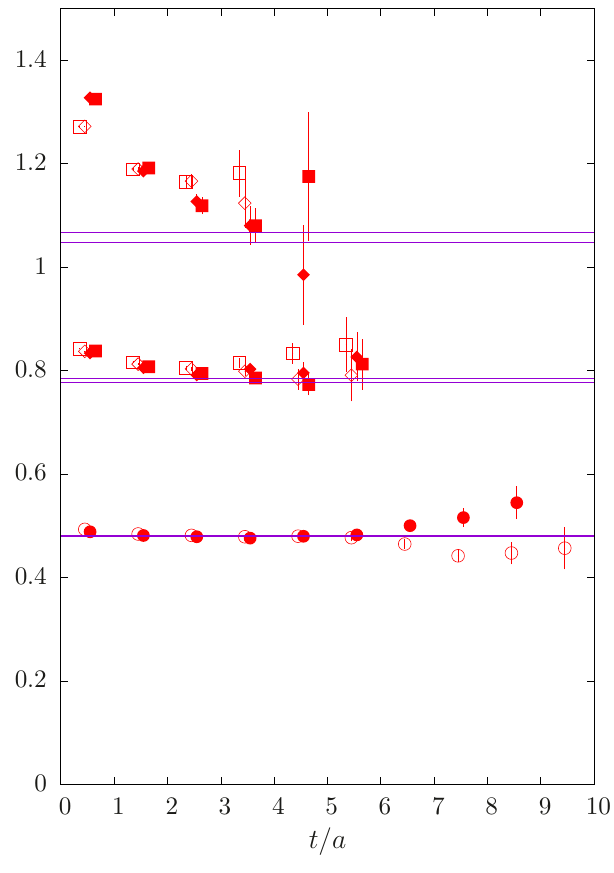
Figure 1 . E(cid:11)ective energies of the lightest glueballs in SO(4) at (cid:12) = 15 : 1 on a 50 2 56 lattice: trace J P = 0 + , , Pfa(cid:14)an ‘0 + ’, , trace 2 (cid:6) , lower (cid:6) , (cid:3) , Pfa(cid:14)an 2 (cid:6) , lower (cid:7) , (cid:4) trace 1 (cid:6) , higher (cid:6) , (cid:3) , (cid:14) (cid:15) Pfa(cid:14)an 1 (cid:6) , higher (cid:7) , (cid:4) . Lines are 0 + , 2 (cid:6) , 1 (cid:6) masses (in ascending order) obtained in SU(2) at (cid:12) = 13 : 87 on the same size lattice. Points shifted for